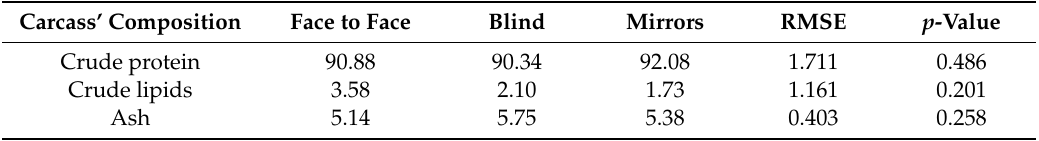
RMSE: root mean square